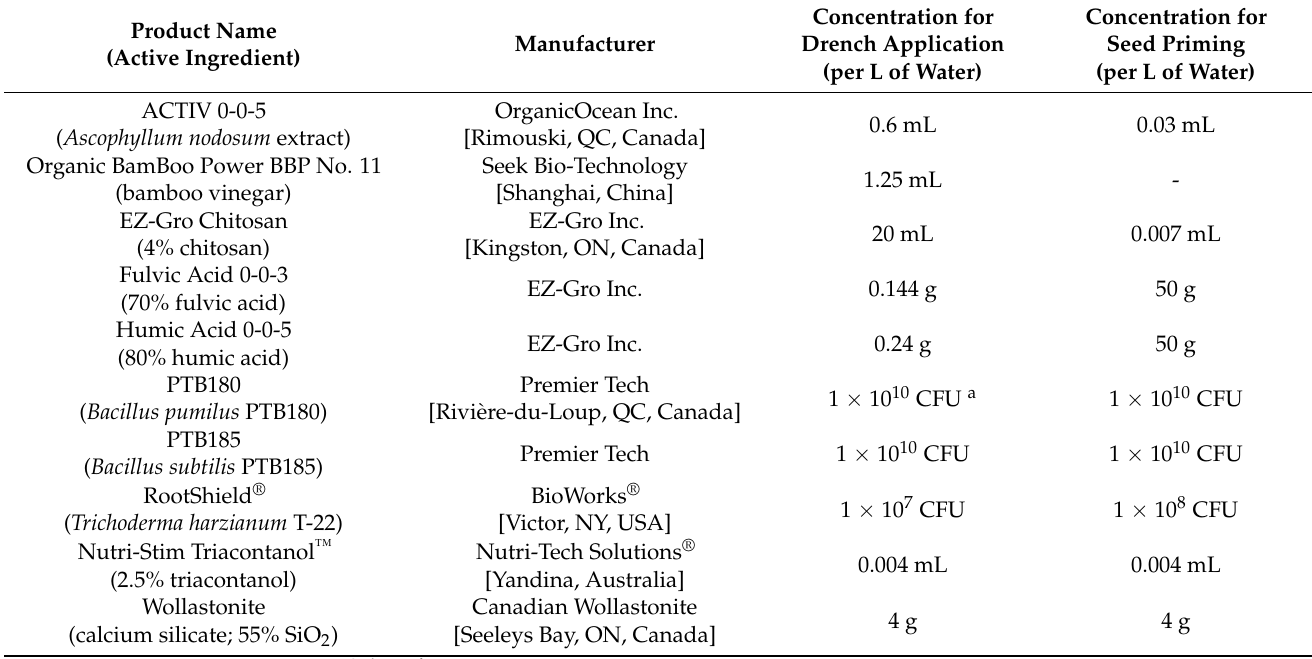
Table 3. Compounds/microorganisms tested for biostimulating activity, and concentrations tested for drench application and seed